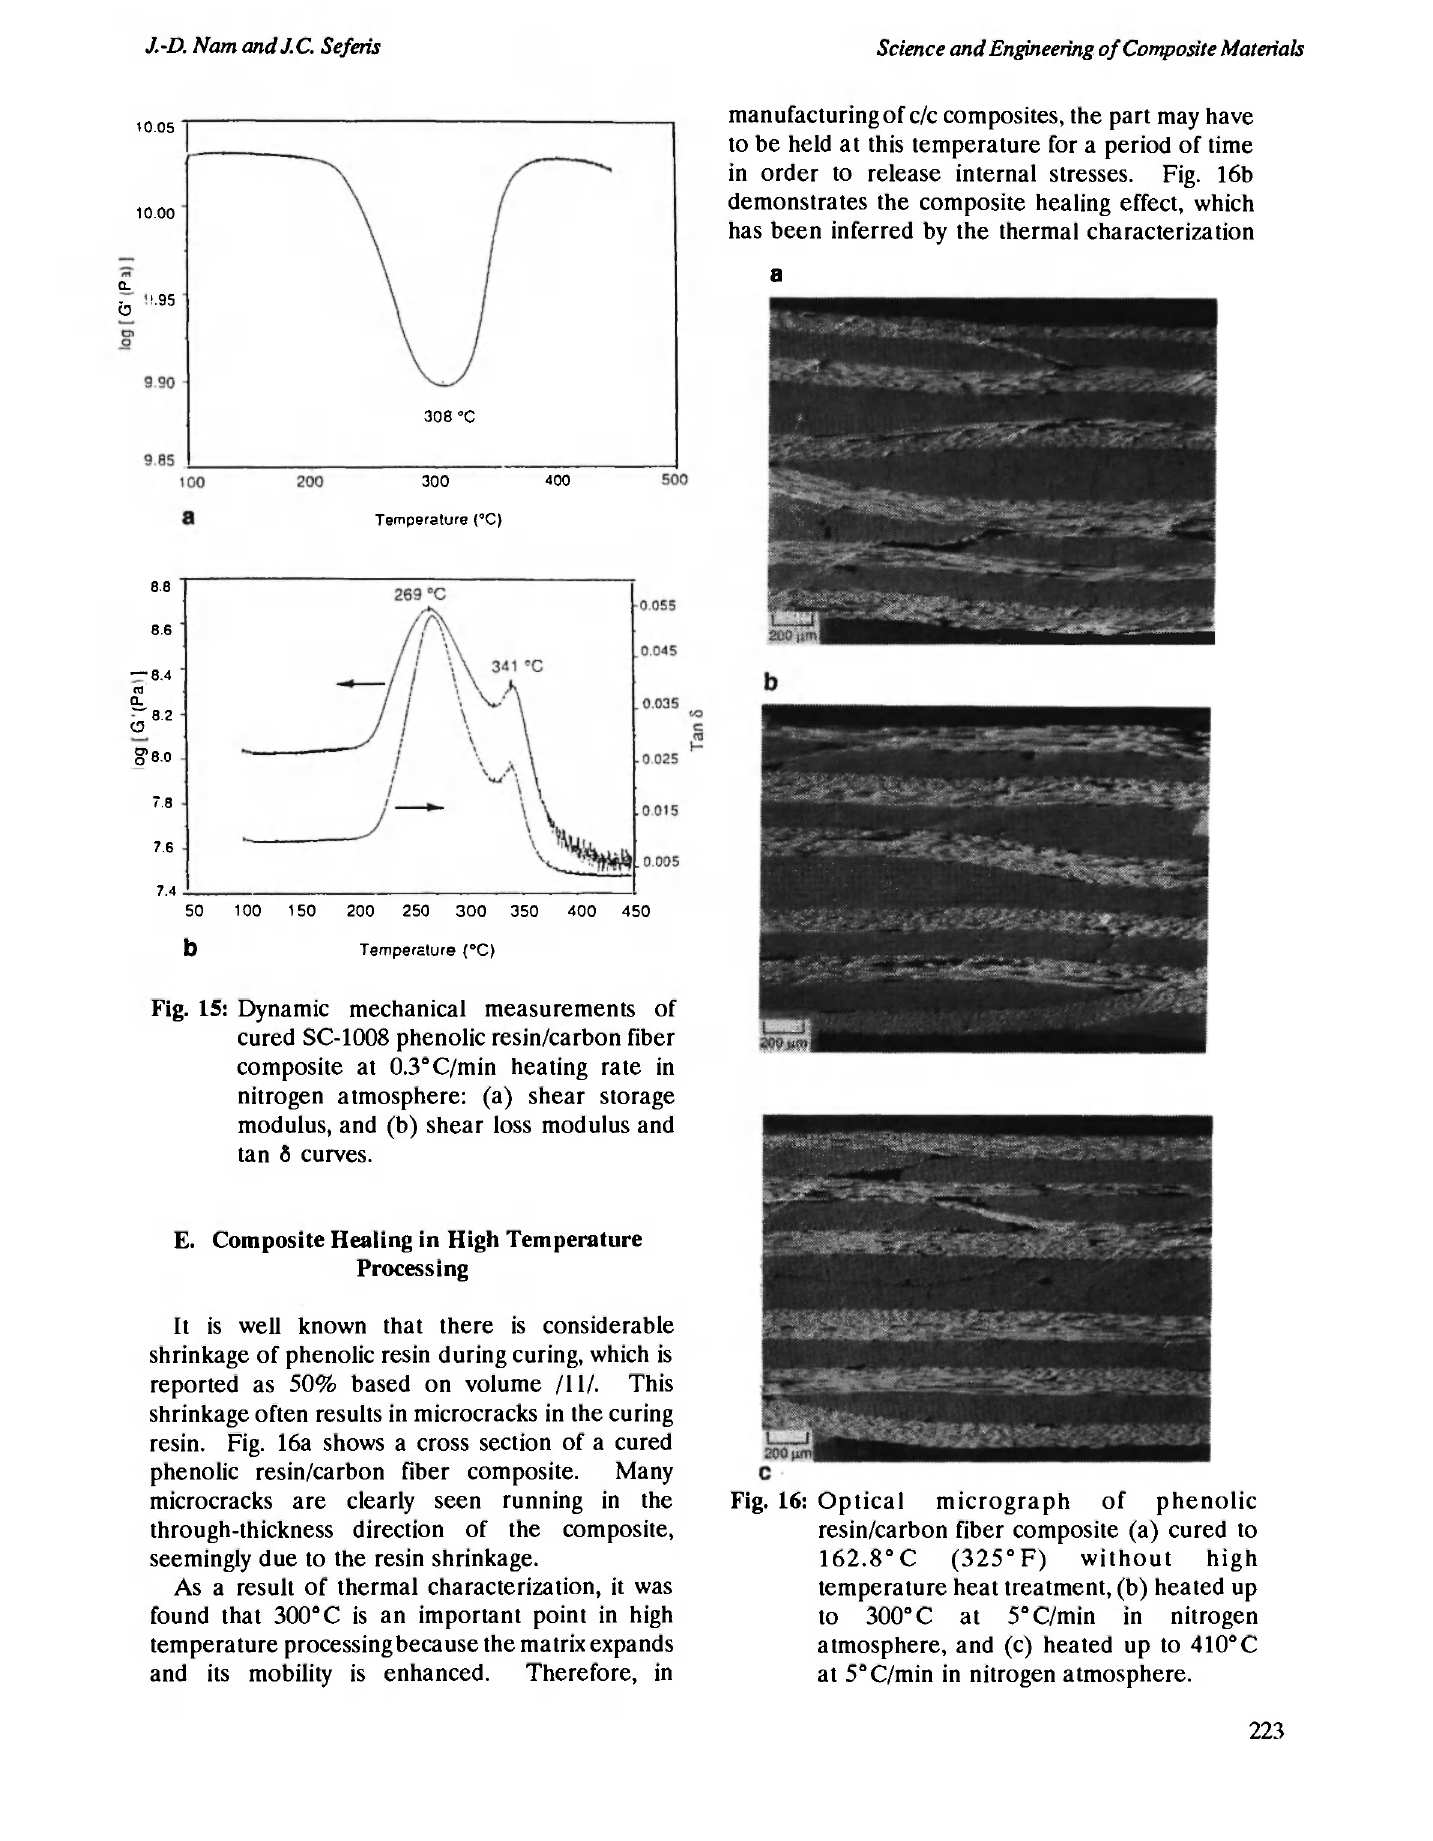
Fig. 16: Optical micrograph of phenolic 162.8°C